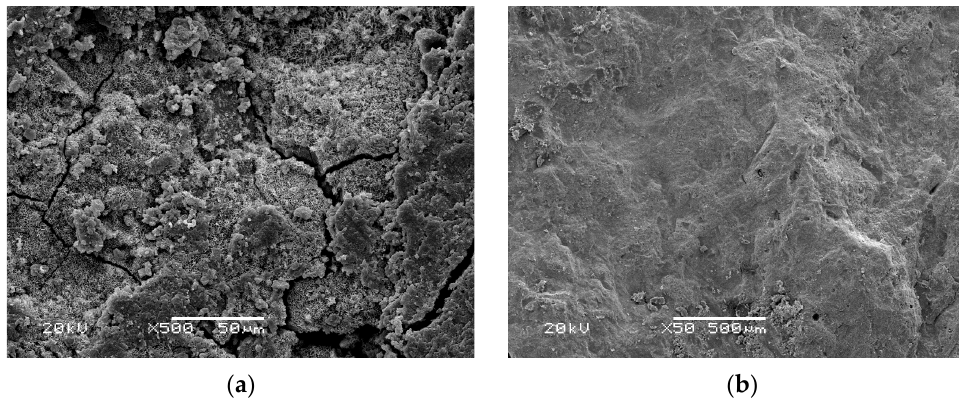
Figure 3. SEM of MOCRC. ( a ) Group A. ( b ) Group B.